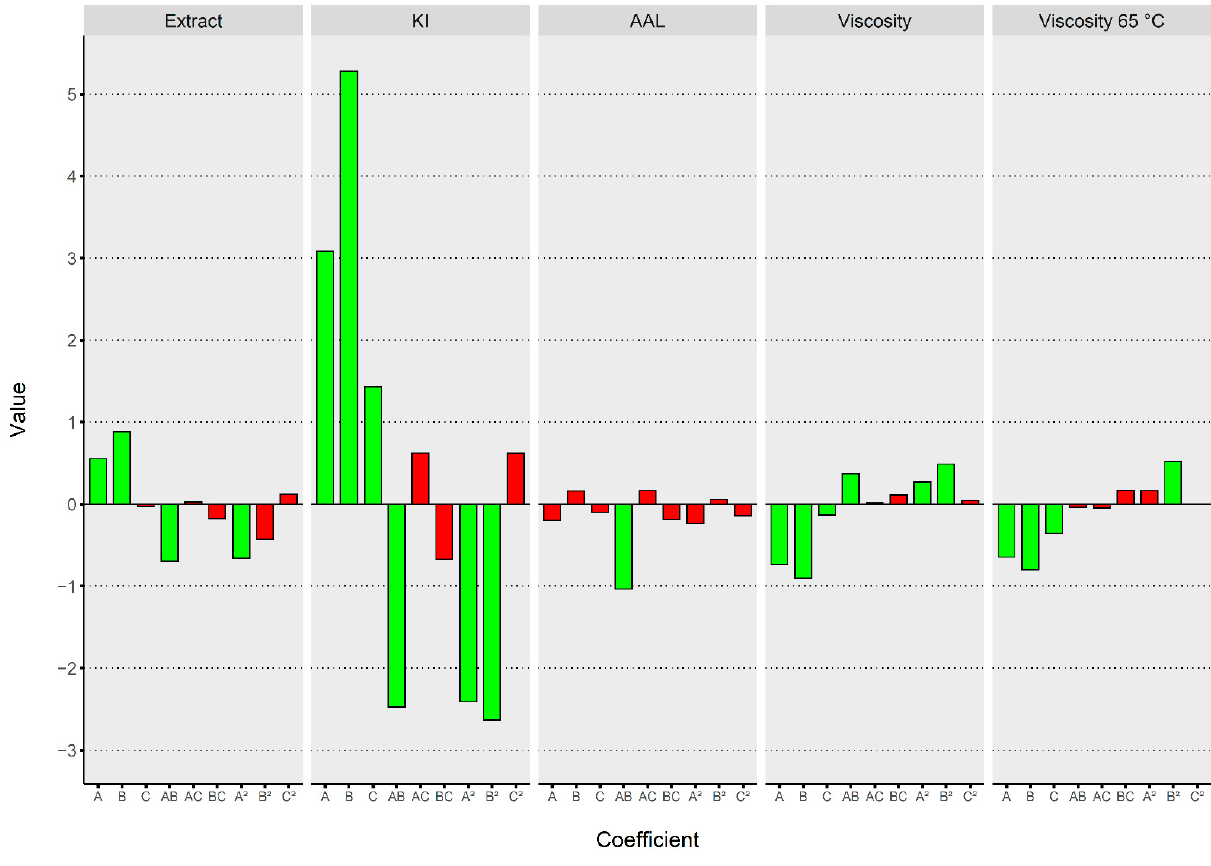
Figure 1. Comparison of coefficient estimates in terms of coded factors. The colors of the bars indicate the significance of each term: green for significant terms, red for non-significant terms. KI, Kolbach index; AAL, apparent attenuation limit; A, germination time; B, germination temperature; C, degree of steeping. Table 2. Analysis of Variance (ANOVA) of the fitted